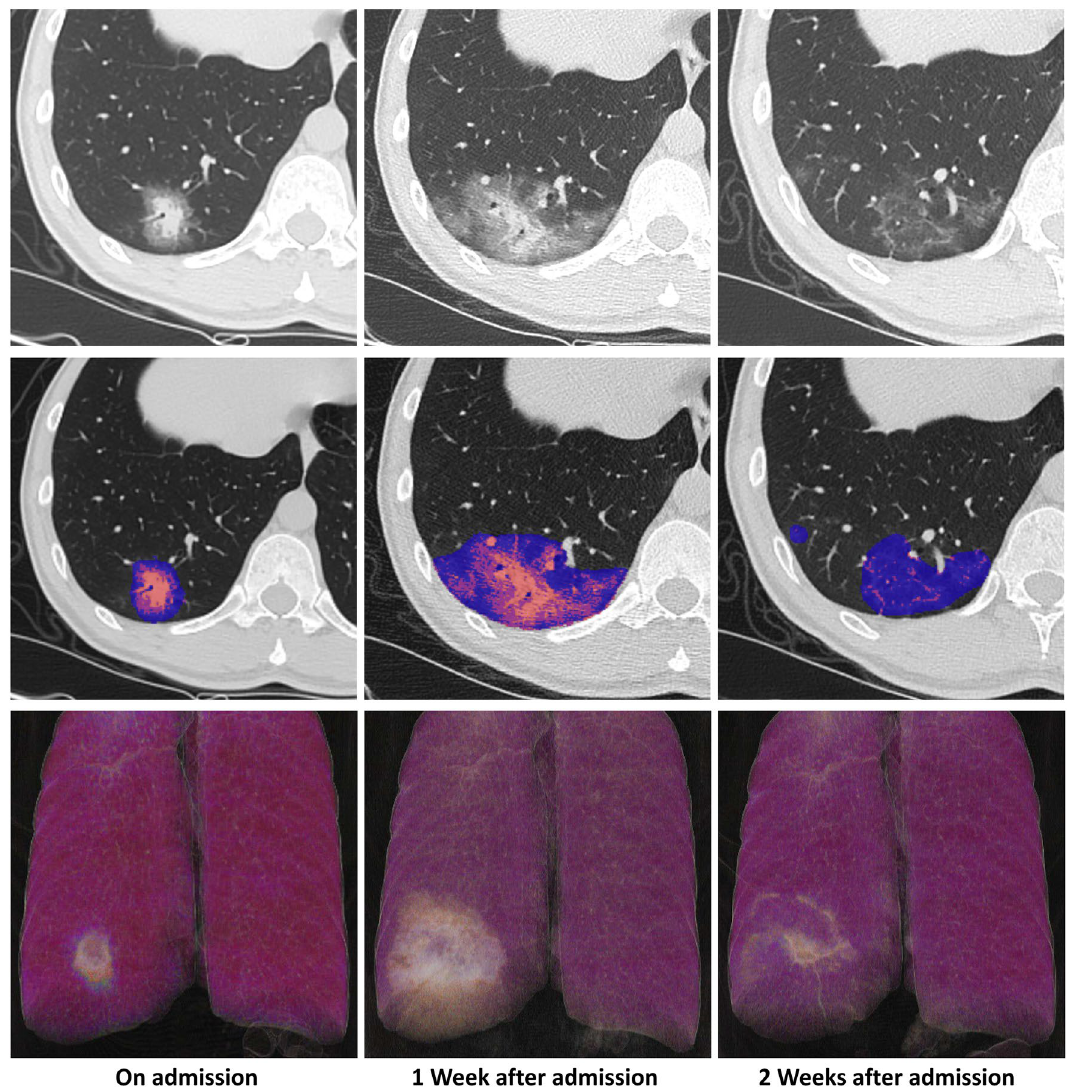
Figure 4. An exemplary illustration of a CT pattern in a moderate patient with COVID-19. Images from a patient presented fever for 6 days and was diagnosed with moderate COVID-19 afterwards. After admission, the serial chest CT scans were performed which demonstrated a dynamic pattern (First row) and the lesions were automatically segmented and color-coded from cold to warm color with the increase of the density using COVID-Lesion Net module (consolidation—orange; GGO—blue) (Second row). On admission (Day 6), a subpleural lesion with mixed lesions as a so-called “halo sign” [consolidation (6.56 cm 3 ) and surrounding GGO (24.18 cm 3 )]. 1 week after admission (Day 13), the lesion was enlarged [consolidation (20.40 cm 3 ) and surrounding GGO (133.60 cm 3 )]. 2 weeks after admission (Day 20), the lesion was partially absorbed leaving irregular residual lesions [consolidation (5.20 cm 3 ) and GGO (46.74 cm 3 )]. The volume rendering images demonstrated the dynamic pattern with time more visually in which the lesions were illustrated as white color (Last